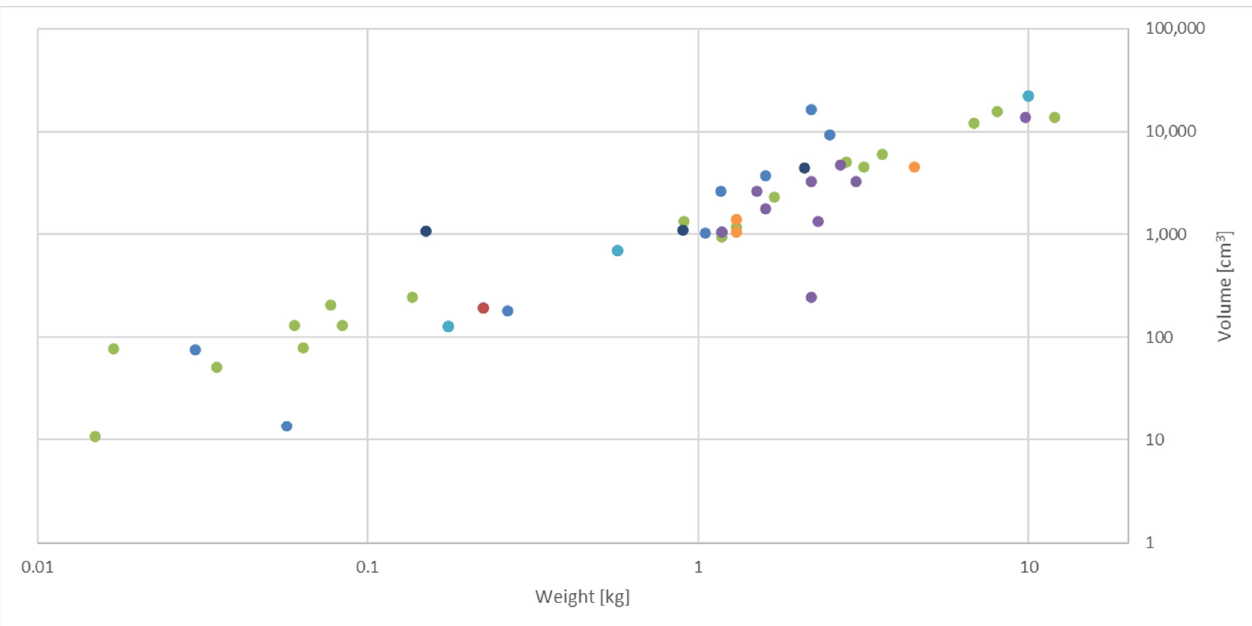
Figure 1. Overview of weight and volume (height × width × length) distribution of some selected commercially available devices used for food authentication according to type of technology (only devices where both weight and size/volume are available are included).